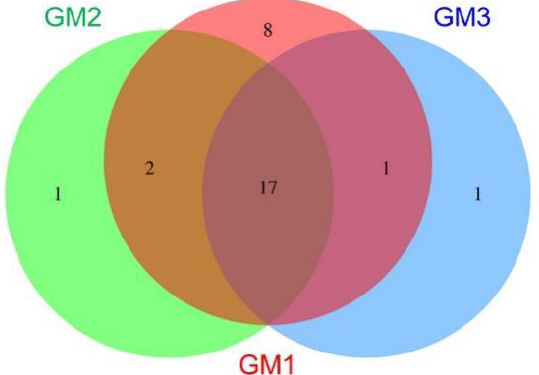
Figure 7. Venn diagram showing the distribution of OTU-affiliated phyla in GM1, GM2, and GM3 speleothems and their intersections. Names of phyla in each intersection and relative compliment are shown in Table 2. Venn diagrams for species, genera, families, orders, and classes are shown in Supplementary Figures S1 – S5. Table 2. Names of phyla in relative compliments and intersections of the Venn diagram (Figure 7). Valid names and candidatus taxa are shown in italic (oblique) and roman (upright) styles, respectively, in the order of read abundance.